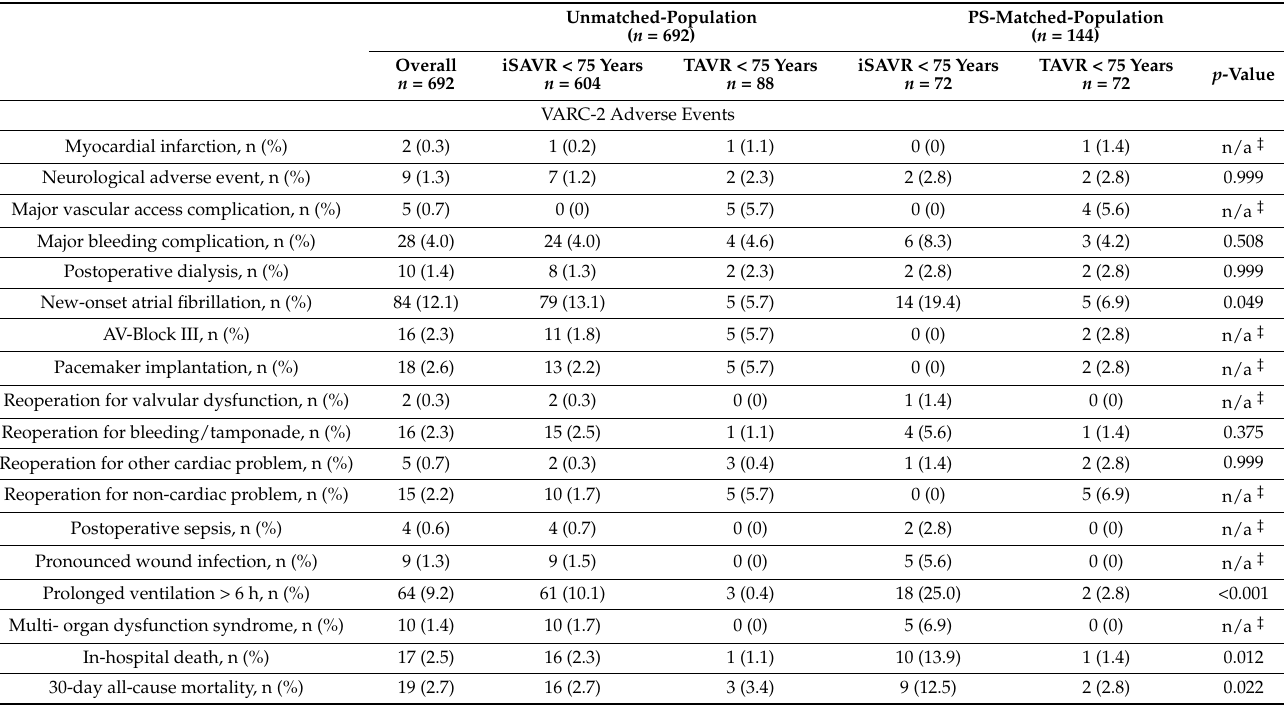
Table 4. Adverse events in the unmatched and matched